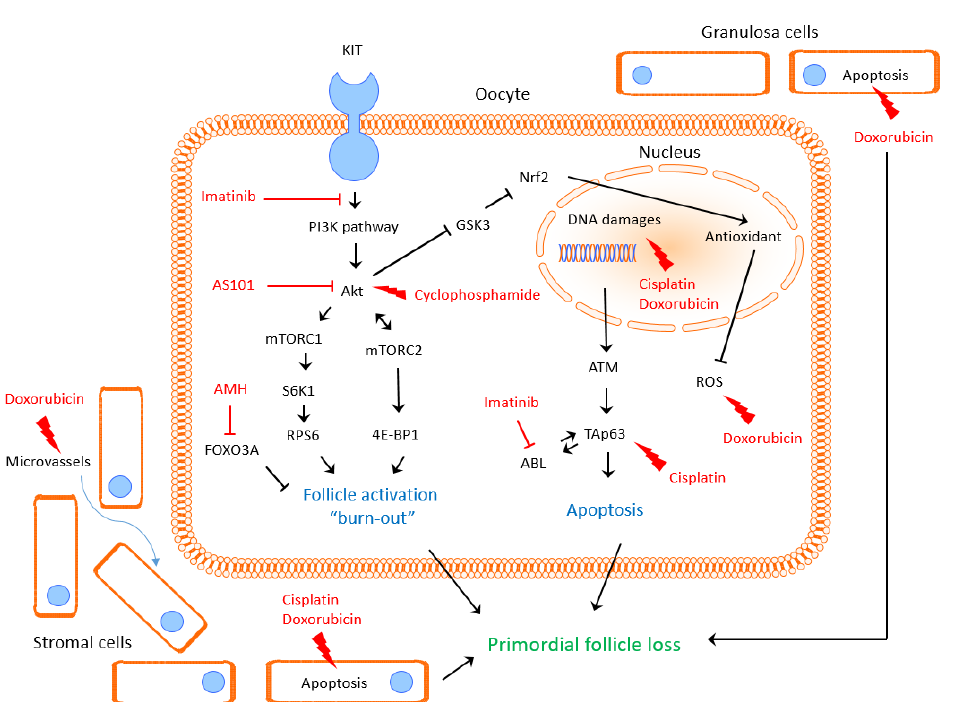
Figure 5. Impact of cytotoxic agents and protective molecules on pathways involved in primordial follicle pool loss.